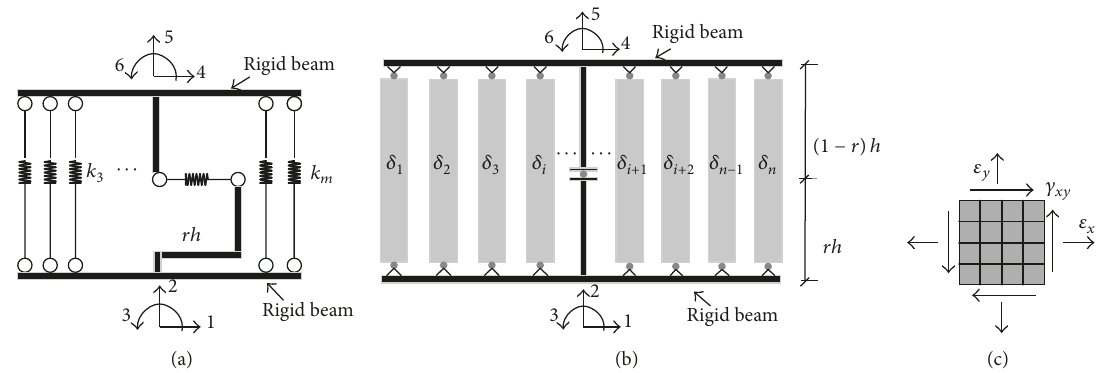
Figure 2: Element models: (a) MVLEM element; (b) SFI-MVLEM element; (c) RC panel element.